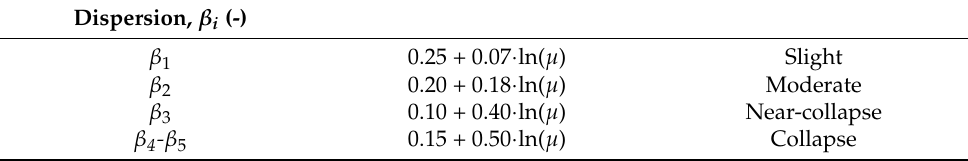
Table 4. Evaluated dispersion, β DS